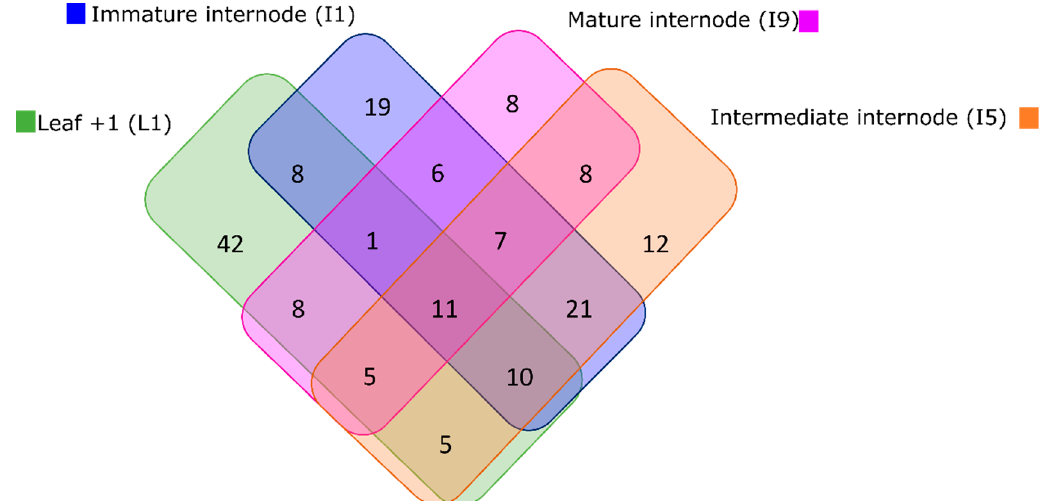
Figure 4. The Venn diagram shows that Leaf +1 presented a higher number of identified metabolites in the metabolite profiles generated via HPLC-MS of each tissue collected throughout sugarcane SP80-3280 development in both fields.